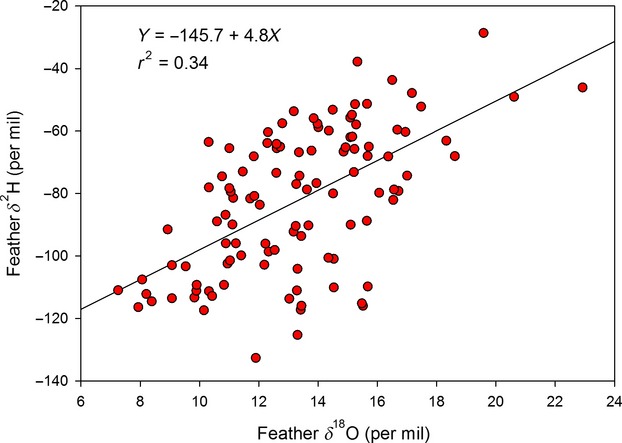
Relationship between feather δ18O and δ2H measured for the sample.